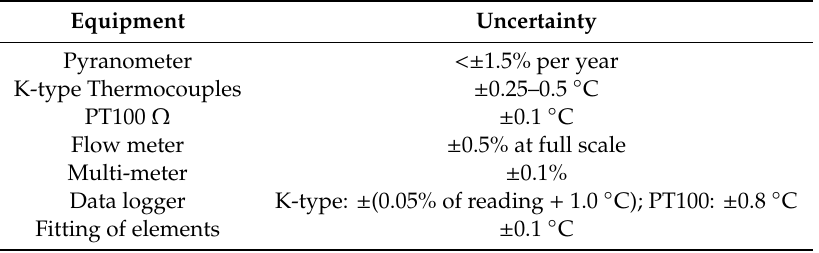
Figure 2. Schematic diagram of the dual-fluid photovoltaic/thermal (PV/T) system. Table 2. Uncertainty related to the measuring equipment.